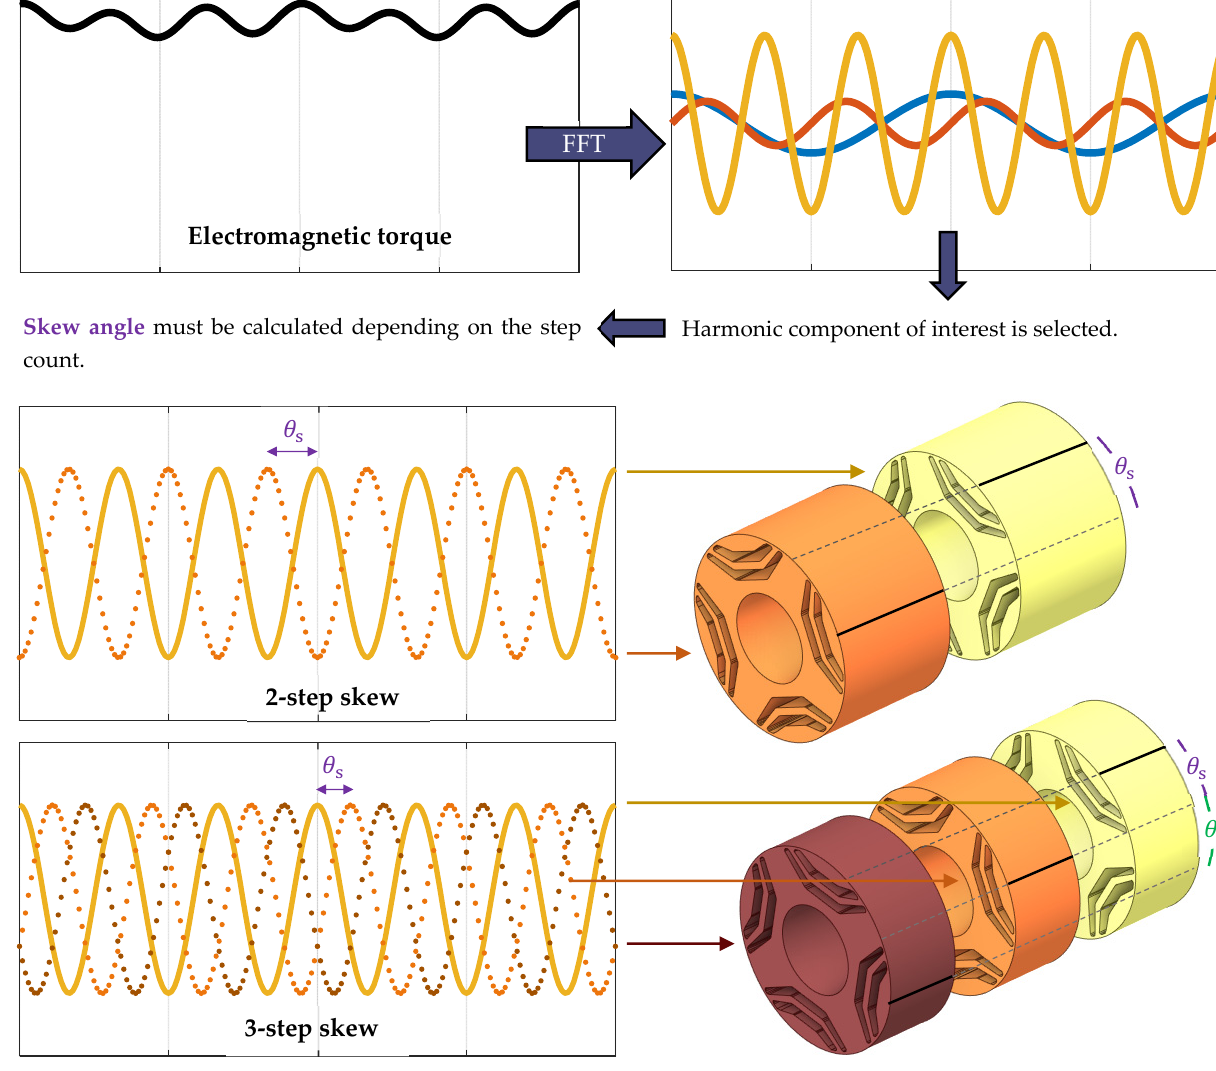
Figure 4. Schematics of the proposed methodology to calculate the skew angle θ s to mitigate a selected harmonic of order w . Two-step and three-step discrete skew are presented, although the method can be used for any number of